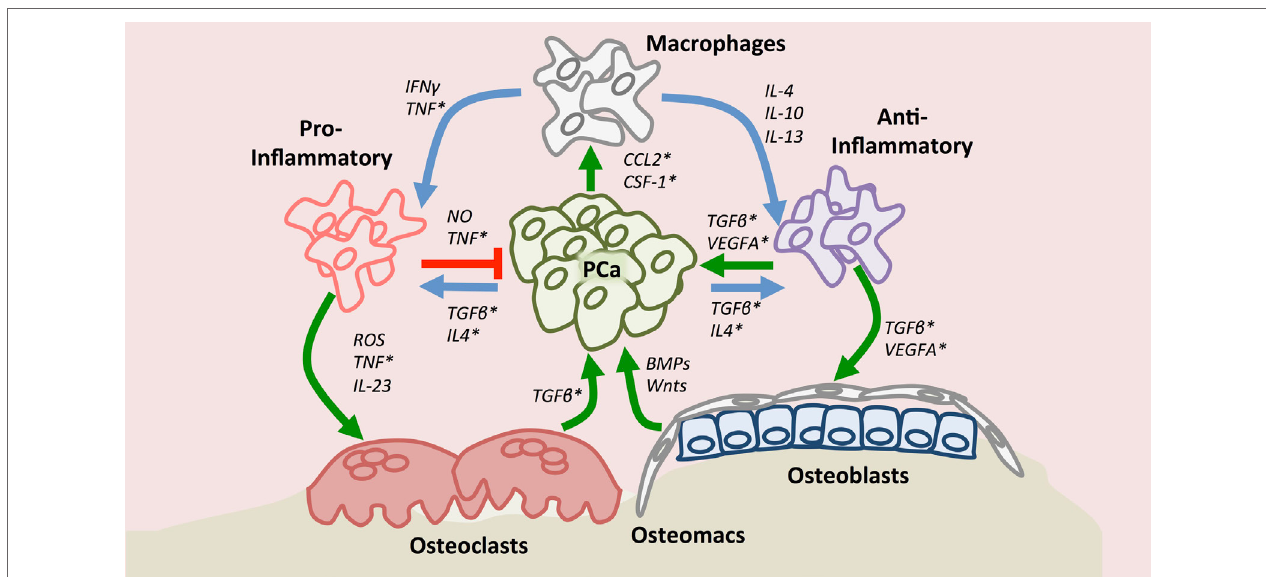
FiGURe 1 | Macrophage roles in the context of the bone-metastatic prostate cancer. Upon recruitment to the site of metastasis by chemokine (C–C motif) ligand 2 and or colony stimulating factor-1, macrophages may polarize (blue arrows) into pro- or anti-inflammatory states depending on environmental cues. Tumor- associated macrophages have protective (red arrow) or contributory effects (green arrow) directly on prostate cancer. Importantly, macrophages, including bone-resident osteomacs, impact osteoclast and osteoblast function (green arrows) thereby also indirectly regulating prostate cancer progression in bone. Asterisks denote factors to which small molecule or biological inhibitors have been